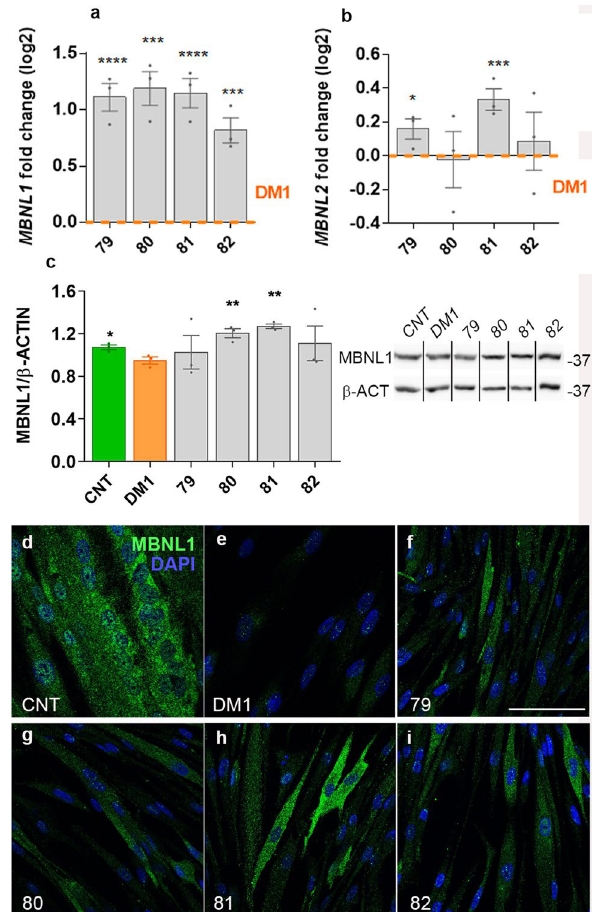
Figure 2. Candidate peptides enhanced the expression of MBNL proteins in a DM1 cell model. Quantification by RT-qPCR of relative expression of MBNL1 and MBNL2 transcripts in DM1 cells differentiated for four days and treated with the four candidate peptides (three biological replicates and three technical replicates per biological sample were performed). Levels were referenced to GAPDH as endogenous control ( a , b ). Western blot quantification relative to beta-Actin confirmed a significant increase in the levels of MBNL1 protein in the cells treated with the 80 and 81 peptides (3 biological replicates per condition). Black lines indicate those lanes cropped from different blots ( c ). The molecular weight marker band at 37 kDa is indicated to the right of the blot. Confocal microscopy micrographs of control (CNT, d ; without DMSO) and DM1 myotubes ( e – i ) treated with vehicle (DMSO 0.1%; e ) or the indicated peptides ( f – i ) stained for MBNL1 (green channel) and DAPI. All images were taken at the same settings. Note the general increase in the intensity of MBNL1 fluorescence in ( f – i ) panels. *p < 0.05, **p < 0.01, ***p < 0.001 according to Student’s t-test. Scale bar corresponds to 100